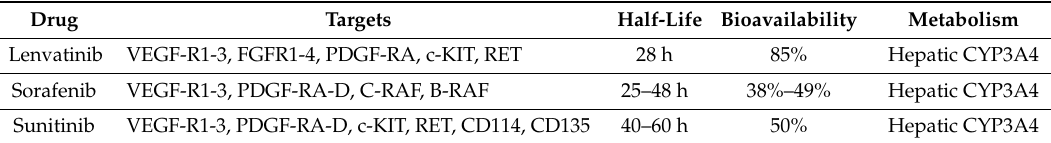
Table 1. Characteristics of lenvatinib, sorafenib, and